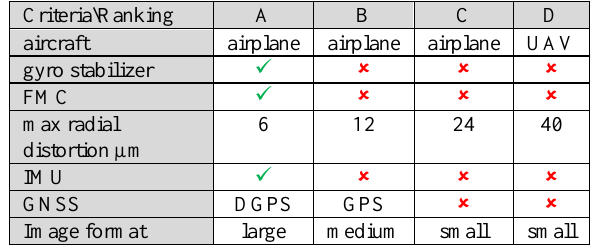
Table 1: Ranking and Criteria of Digital Aerial